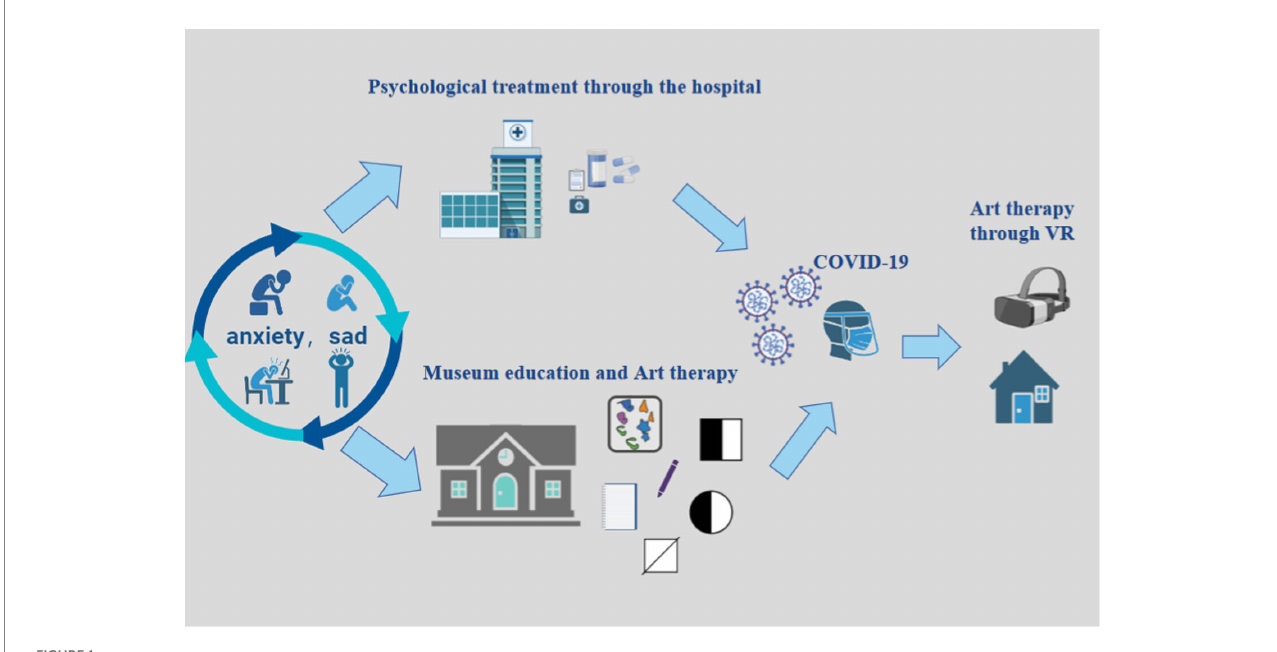
FIGURE 1 Generalized diagram of museum education and art